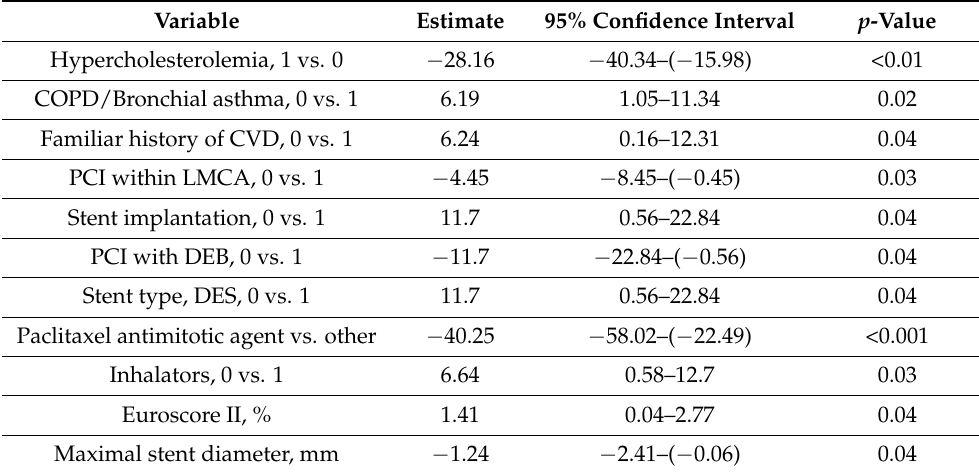
Table 7. Predictors of stent underexpansion—simple linear univariable